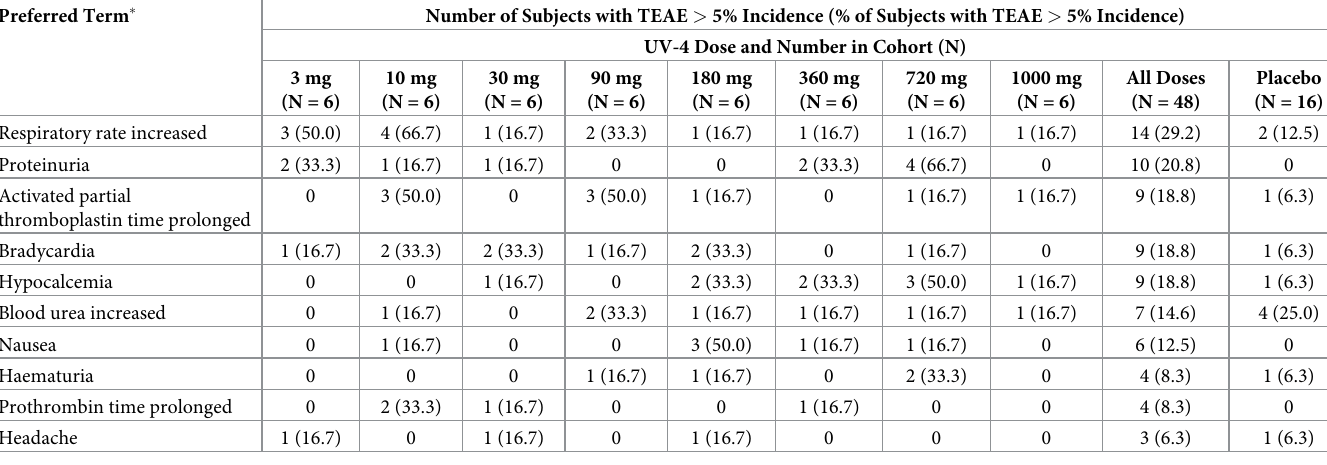
Table 3. Summary of Subjects with Treatment-Emergent Adverse Events with Incidence Greater Than 5% Among UV-4-Treated Subjects. Preferred Term �